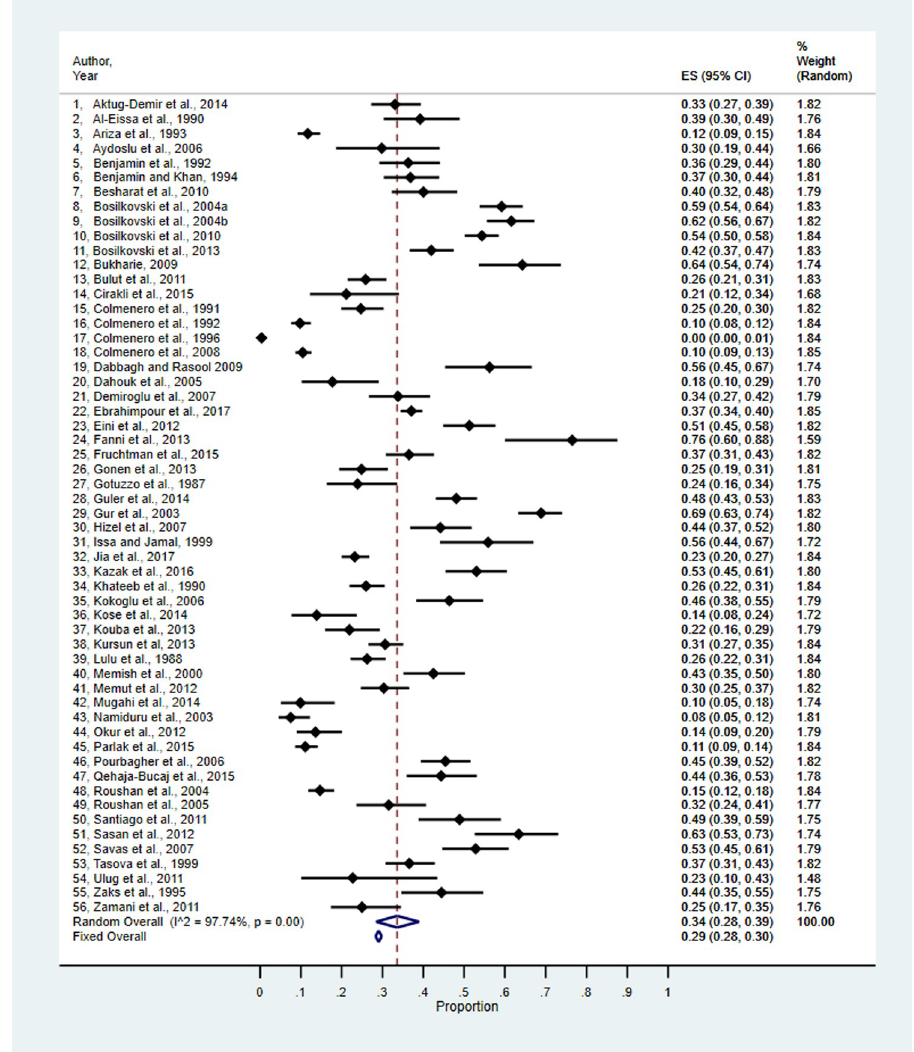
Fig 2. Metaprop results of prevalence estimates of osteoarticular